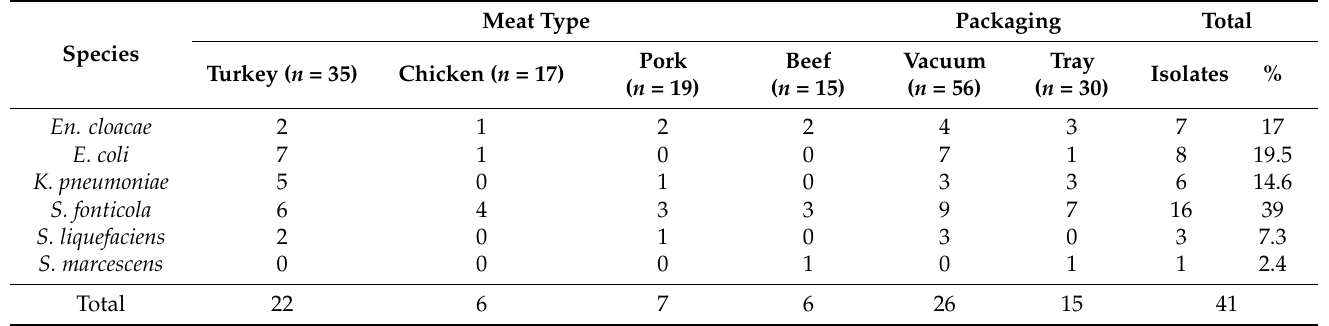
Table 3. Cephalosporin-resistant strains isolated from meat samples ( n = 86) collected from markets in Gdansk. In a few cases, multiple strains were isolated from 1